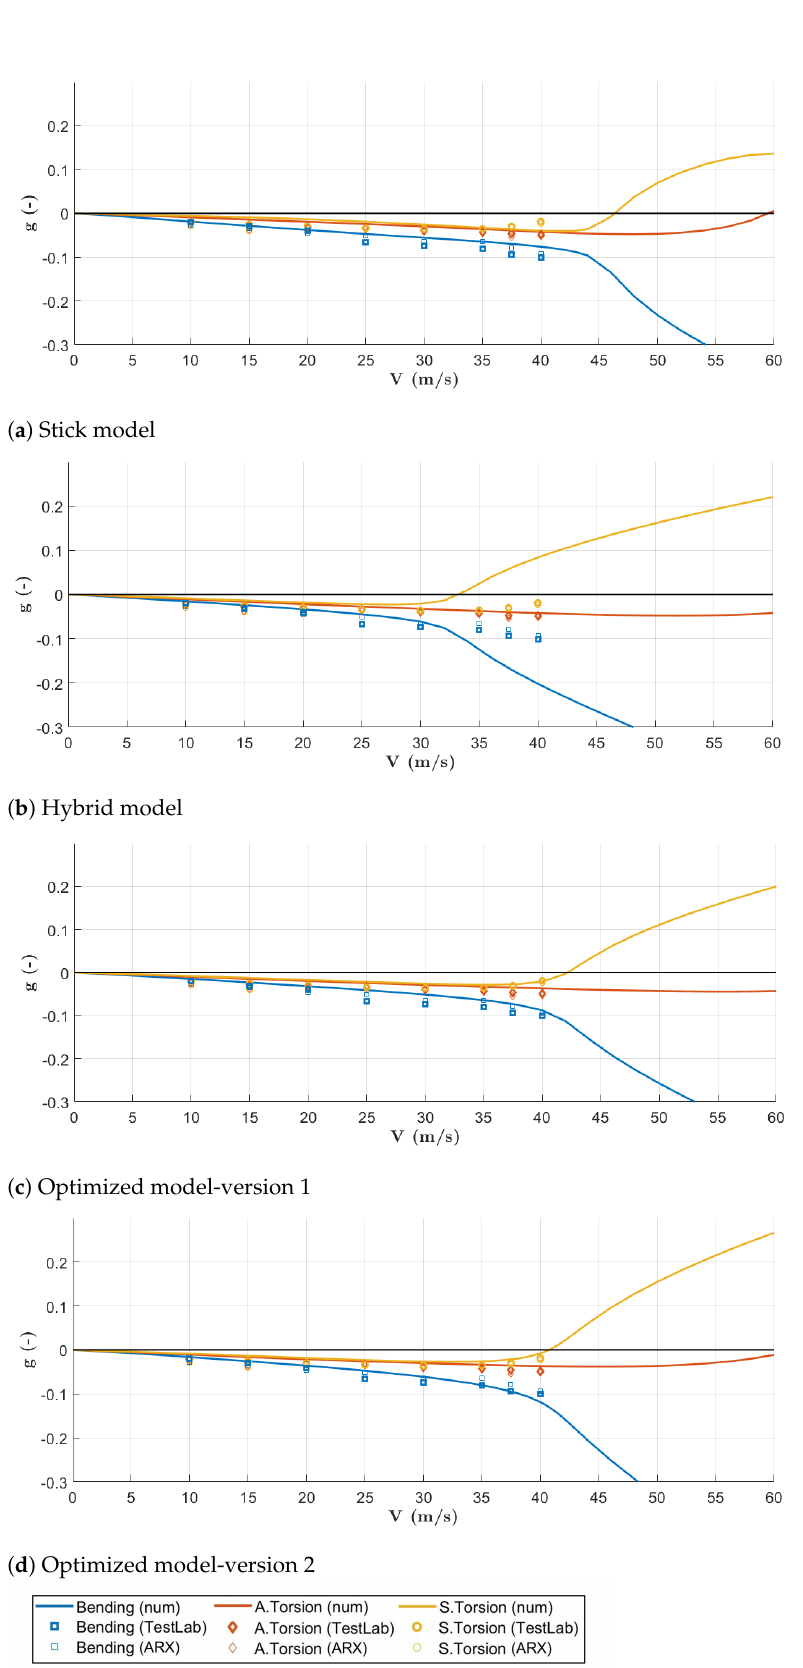
Figure 14. V − g plots of the mass-backward